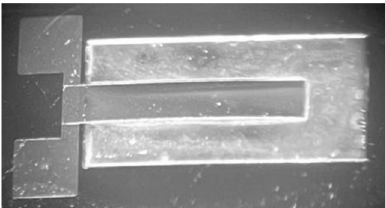
8 of 9 Figure 6. The Physical image of a cantilever beam with different SiO 2 /SiN x thickness. ( a ) 1# SiO 2 /SiN x : 1.25/0.75 ( μ m); ( b ) 2# SiO 2 /SiN x : 1/1 ( μ m); ( c ) 3# SiO 2 /SiN x : 0.75/1.25 ( μ m); ( d ) 4# SiO 2 /SiN x : 0.5/1.5 ( μ m); ( e ) 5# SiO 2 /SiN x : 0.25/1.75 ( μ m). Fixing the size of the cantilever beam, it can be seen that the deformation of the com- posite film decreases with the decrease in the thickness of SiO 2 , and decreases with the increases in the thickness of the SiN x from the Figure 4. This is because the SiO 2 film pre- sents compressive stress during the production process, and the SiNx film presents tensile stress during the production process. The stress produced by SiO 2 of the same thickness is greater than the stress produced by SiN x . After the sacrificial layer is removed, the stress is released and the cantilever beam is deformed. The thickness ratio of SiO 2 /SiN x changes the position of the neutral axis of the composite film, changes the radius of curvature, and improves the deformation of the cantilever caused by the internal residual stress after the